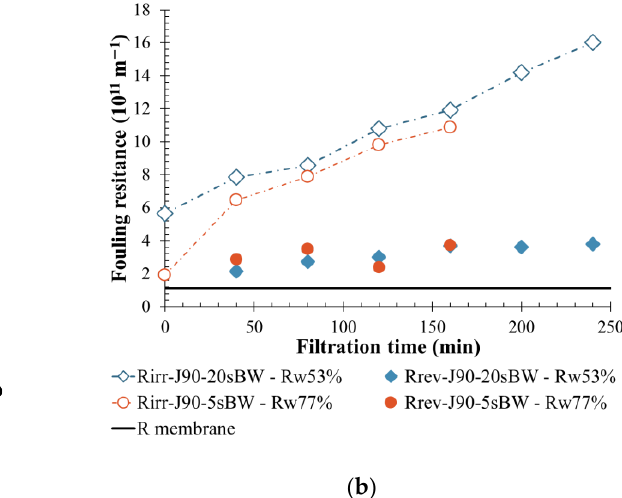
Figure 8. Influence of BW duration on membrane filtration behavior by variation of permeability at 20 °C ( a ) and fouling resistance ( b ) throughout the time with permeate flux of 150 L h −1 m −2 , a BW interval of 40 min and a BW duration of 5 s (squared) and 20 s (round) are applied to the membrane. T = 20 °C, feedwater from APL - SINGAPURA-ME; SiC membrane 0.33 m 2 . Jxx is permeate flux at the xx value in L h −1 m −2 ; 1BW yy s/zz min where yy is the duration and zz the interval of filtration between two BW; and Rw is the total recovery rate applied on the unit; R irr is irreversible resistance; R rev is reversible resistance and R membrane is the membrane resistance.